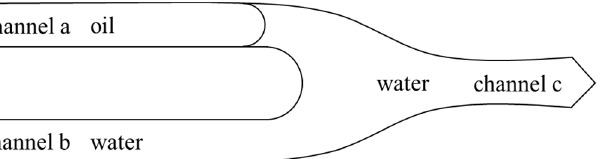
Figure 13. Schematic diagram of the blocking effect in the capillary tube. Different flow paths are distinguished by a–c.